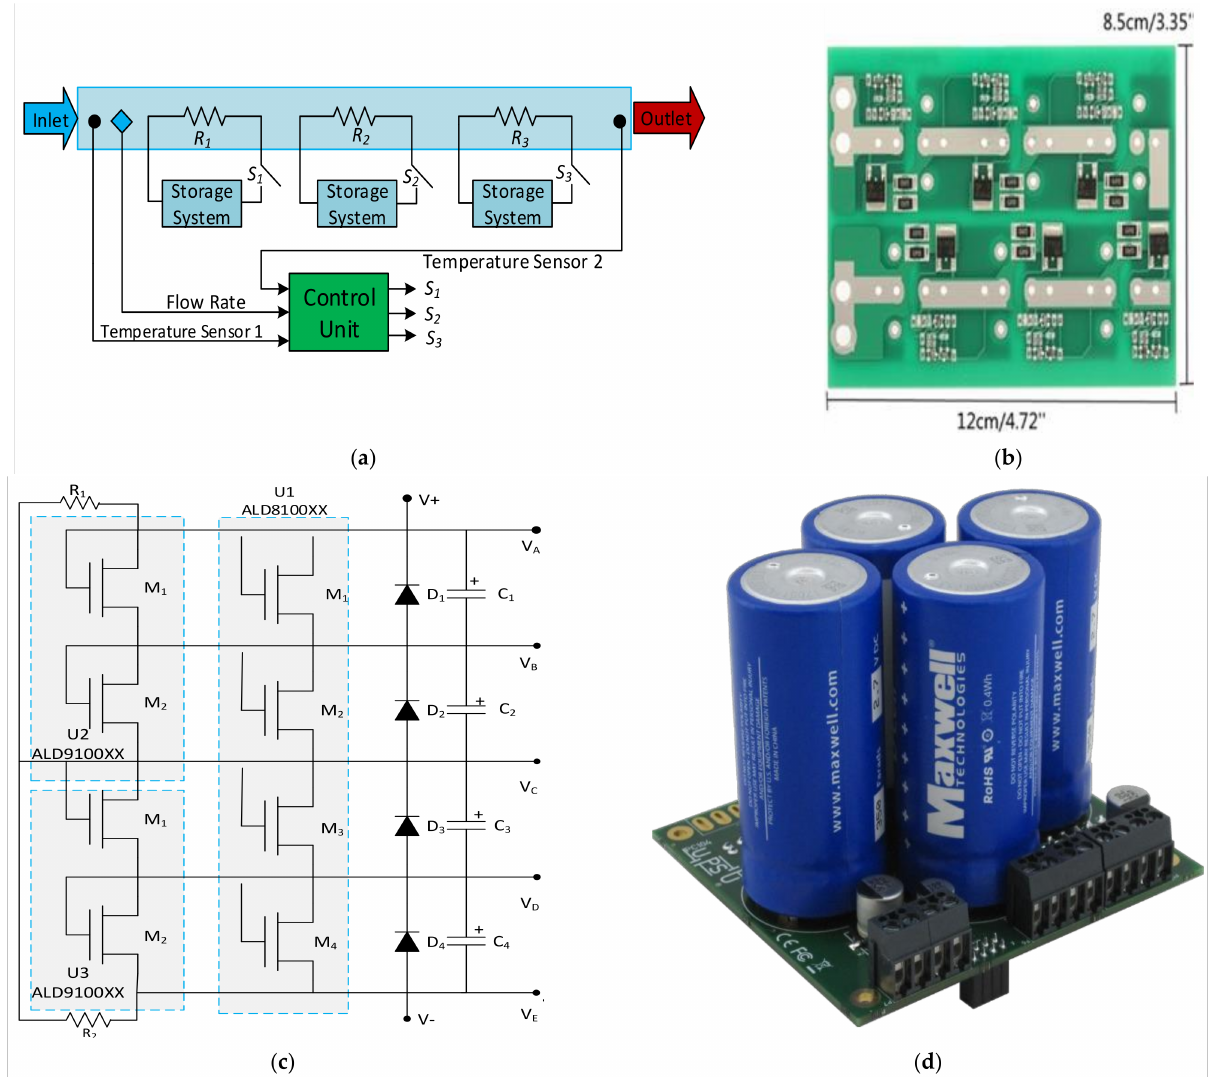
Figure 17. ( a ) Implementation of the SCATMA technique. ( b ) A six-string supercapacitor protection board [173]. ( c ) A circuit diagram of the protection board [60]. ( d ) An example commercial product for the SC module